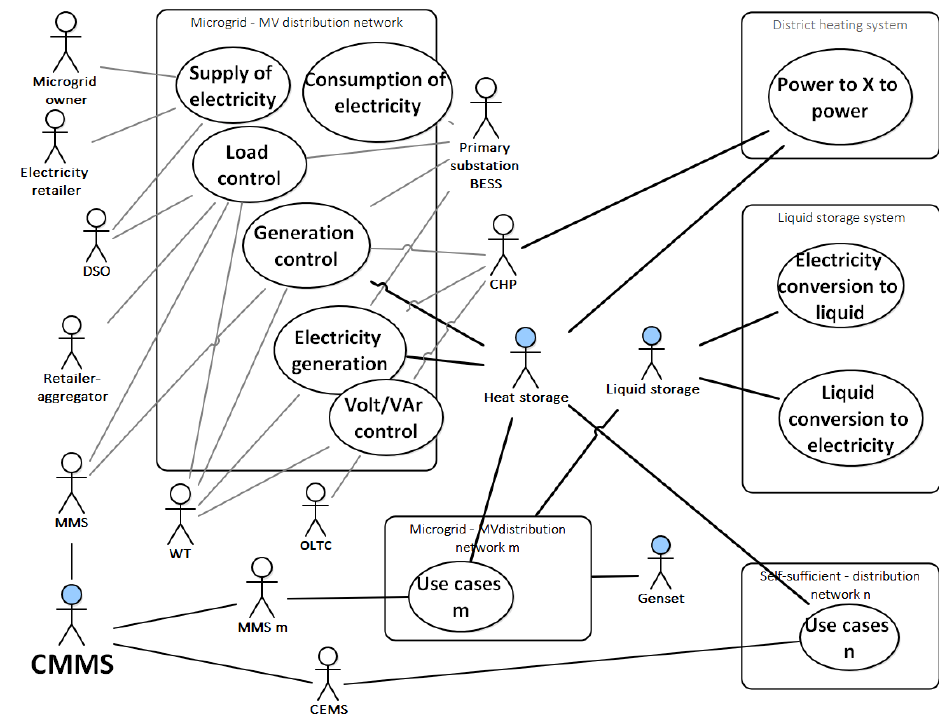
Figure 4. High-level use case diagram of energy management of the MV distribution network in the intelligent microgrid network phase.